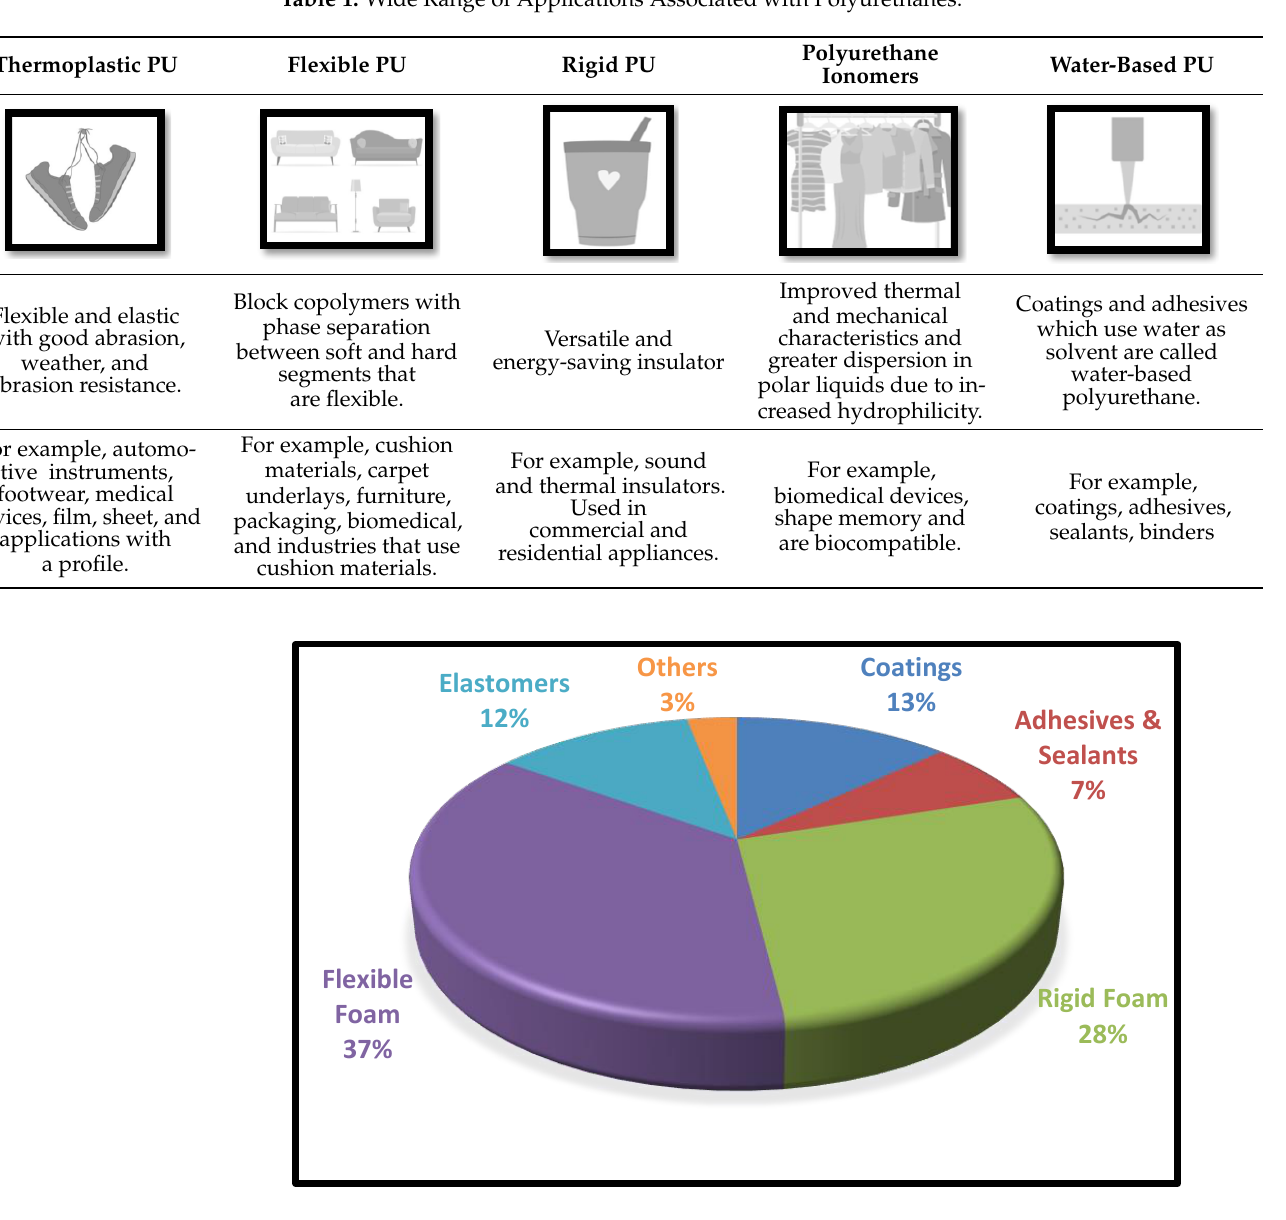
2 Figure 1. Formation of Urethane Linkage.